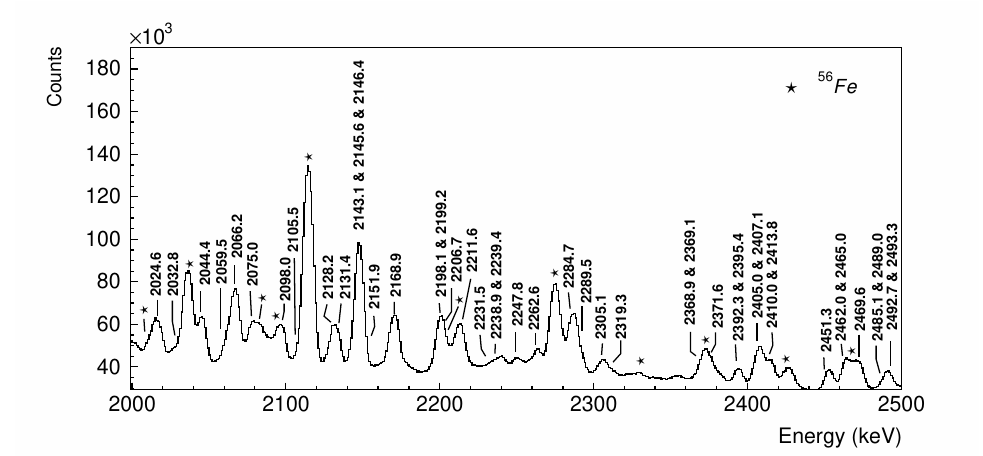
Figure 2. The γ - γ coincidence matrix-projection spectrum is shown, in the 2-2.5 MeV range. All the γ -rays observed and placed in the level scheme of 56 Co in this work are labelled. Note that the peaks coming from the de-excitation of excited states in 56 Fe are indicated with a symbol ?